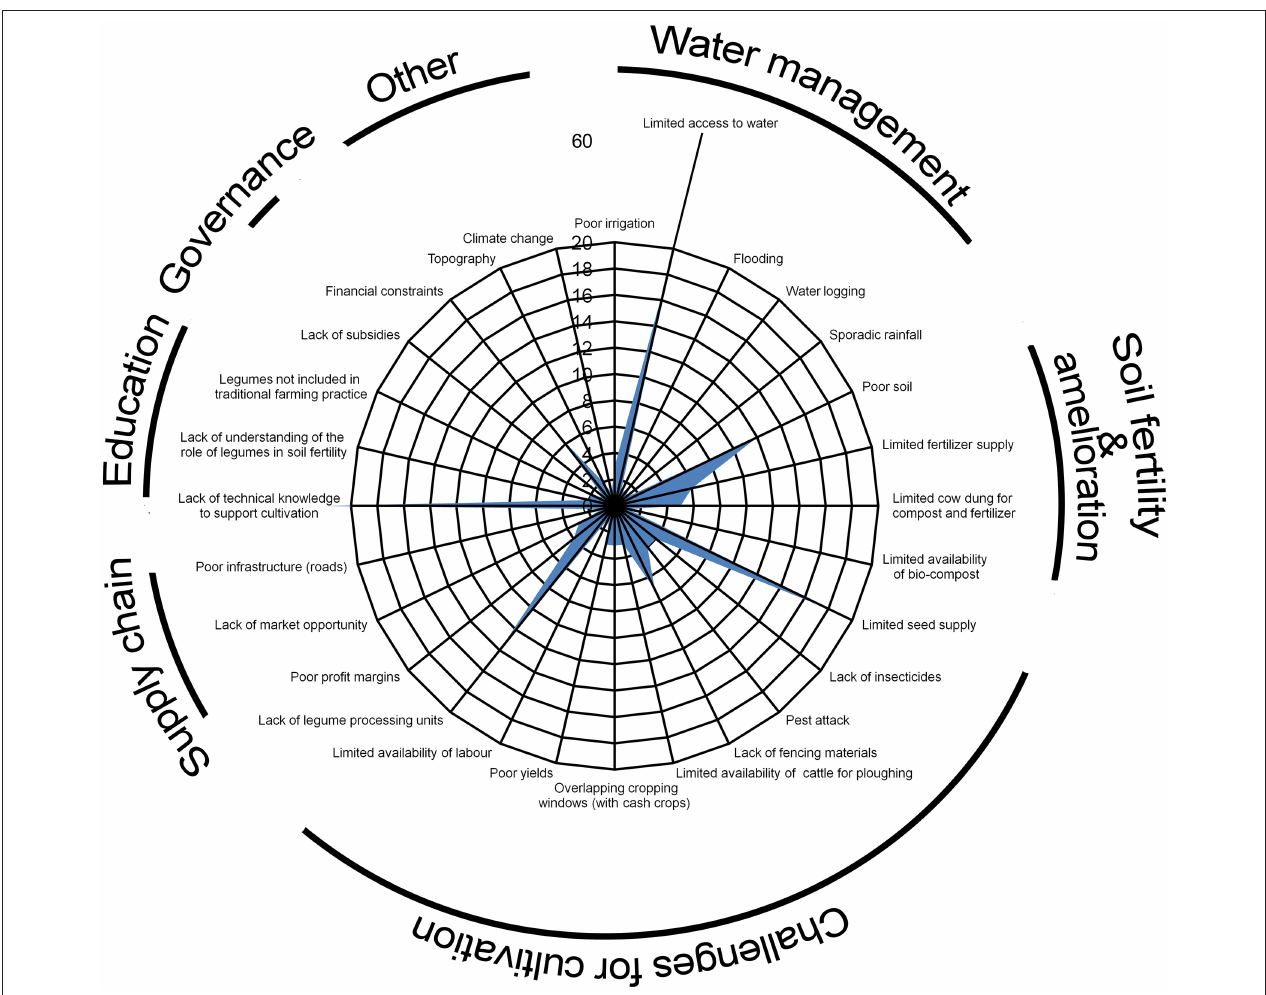
FIGURE 1 | Barriers to grain legume production as identified by farmers. The Y axis indicates the number of farmer groups that identified each Barrier.